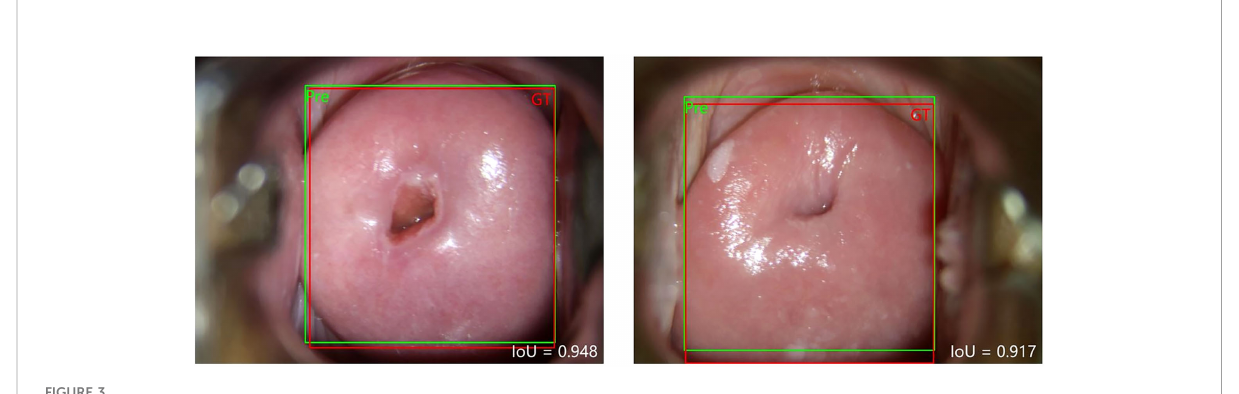
FIGURE 3 The graphical result of the improved Faster